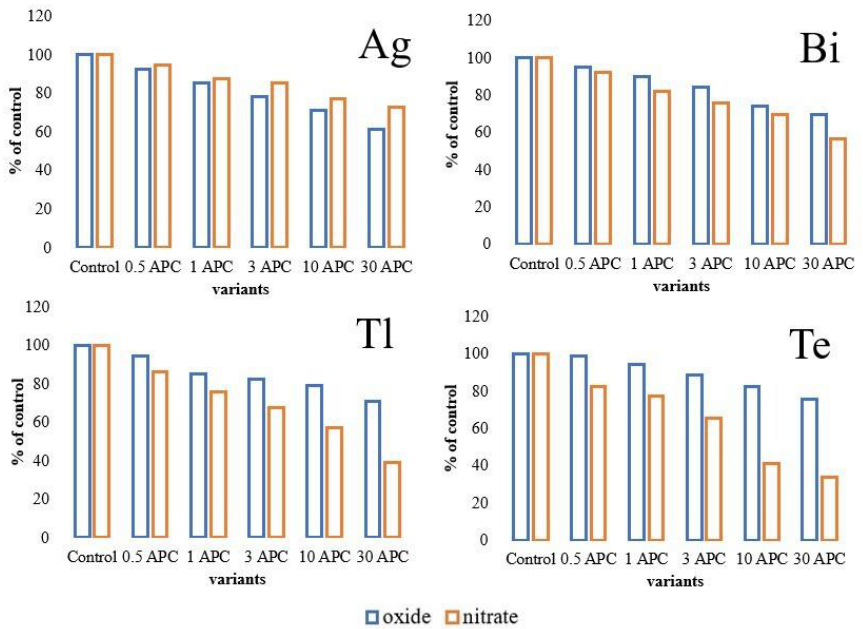
Figure 7. Integral indicator of the enzymatic activity in chernozem when contaminated with oxides and nitrates of Ag, Bi, Tl, and Te, % of the control. Tl nitrate toxicity compared to its oxide was detected already with 0.5 APC — 8%;